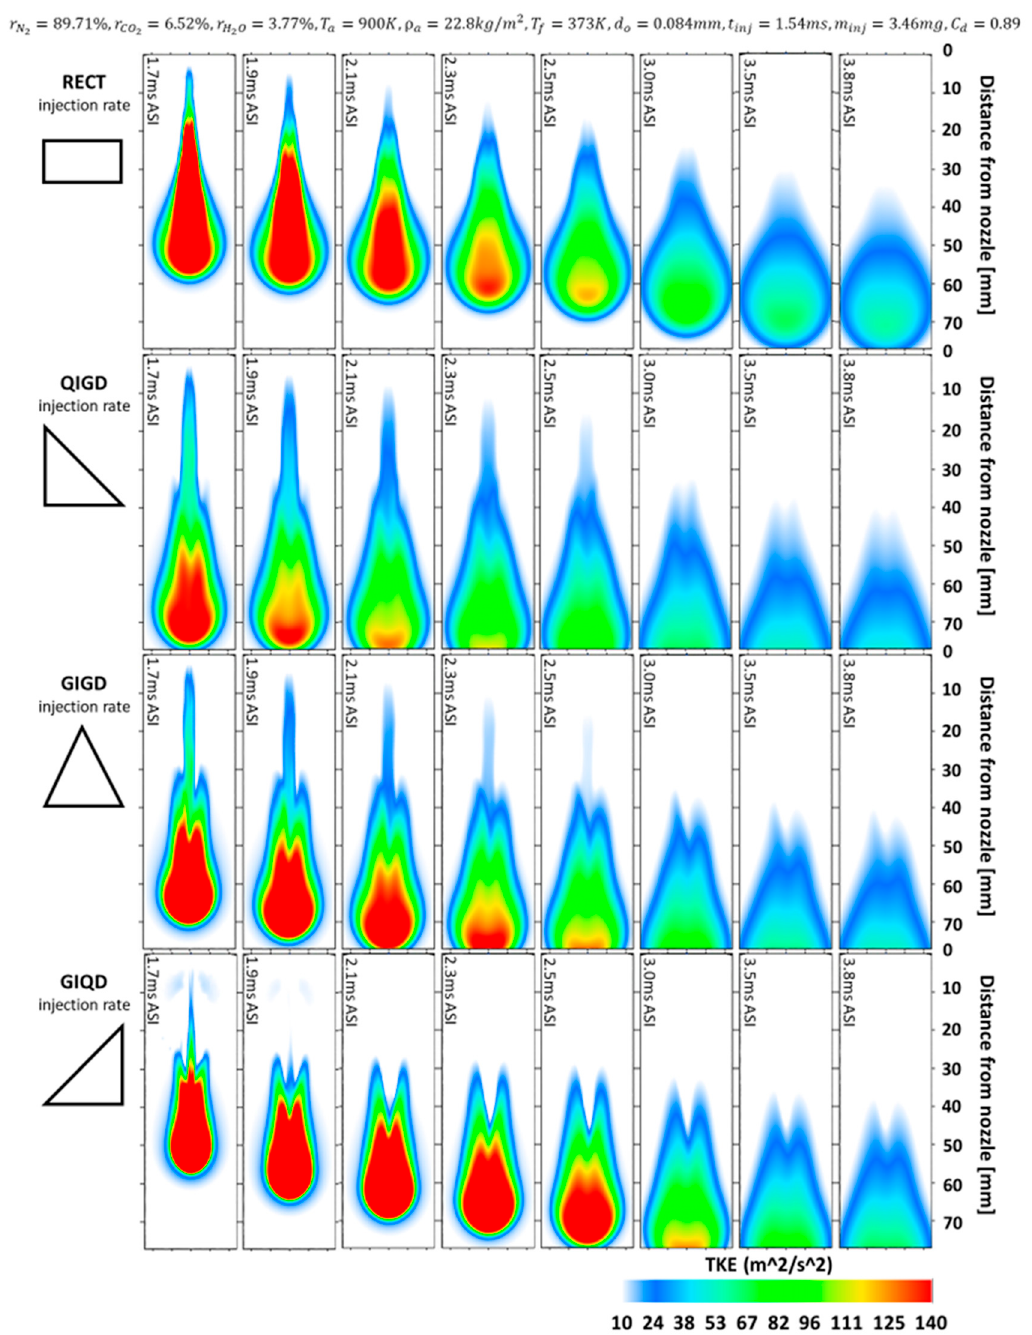
Figure 24. Comparison of the TKE distribution after the EOI for different injection rate shapes.